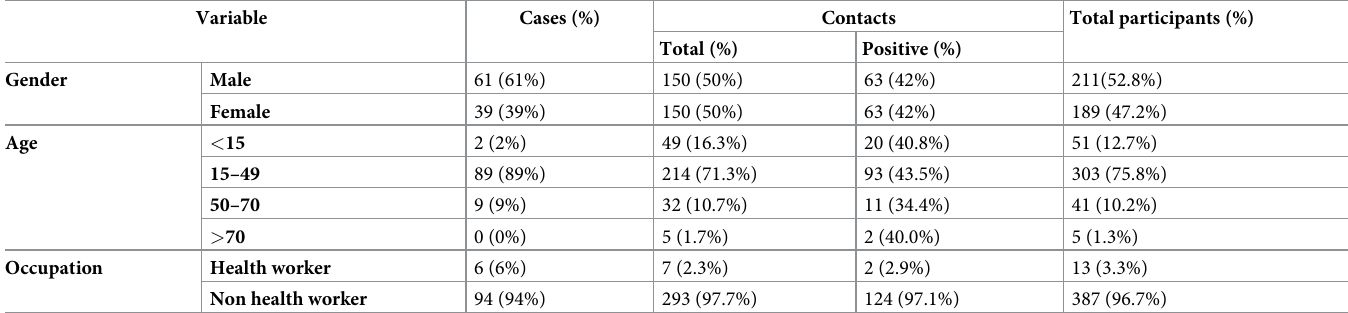
Table 1. Socio-demographic characteristics of the cases and close contacts, Ethiopia, 15 May to 15 June